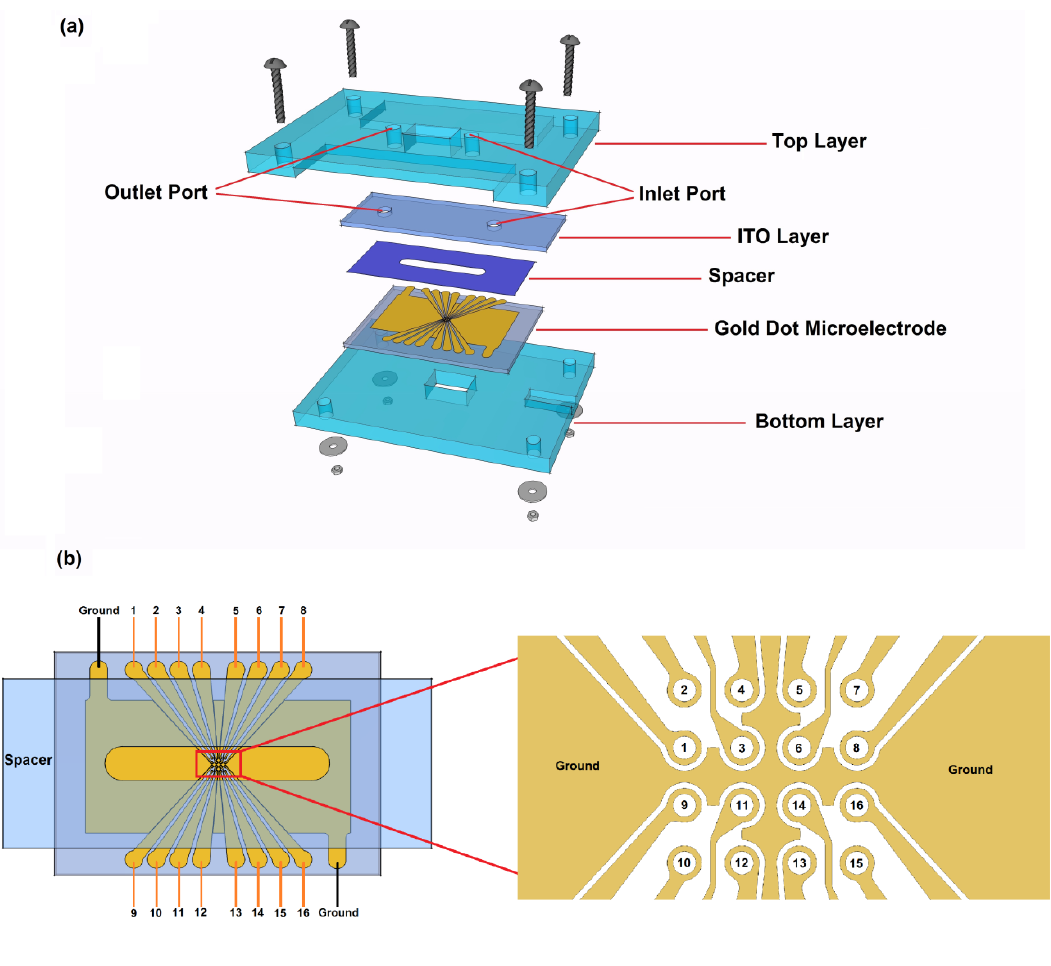
Figure 1. The LOC device design. ( a ) A schematic illustration of the proposed Lab-on-a-Chip device; ( b ) A high-resolution view of the proposed 4 × 4 microarray dot electrode. Sixteen individual inputs can be supplied simultaneously. Figure 1a reproduced with permission from